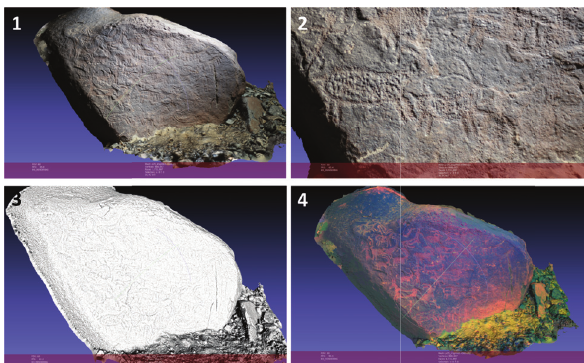
Figure 6. Raw image acqui with indir light durin night (panel 6 68) (above). F Figure 6.1-6.2 High resolutio model and de etail. Figure 6.3 3 3D model w with radiance sc th Meshlab. Fig gure 6.4 Final 3D model colorspace YBK TAL TRACIN mperative the fa orts ” (Sauvet, 2